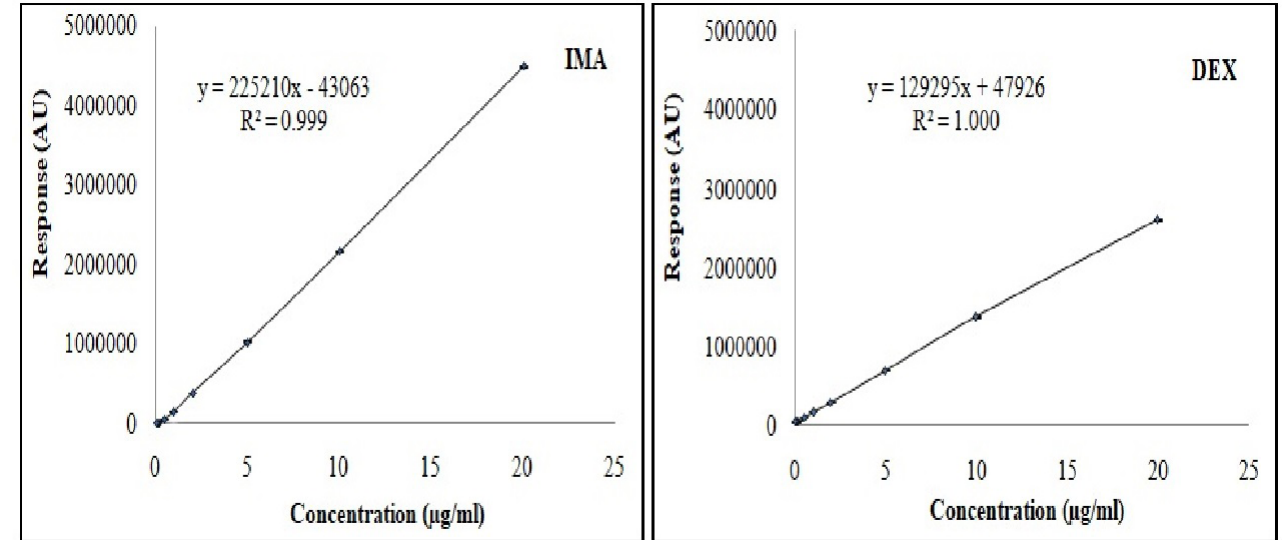
FIGURE 5 - The calibration curves of imatinib mesylate and dexketoprofen trometamol in DMEM (n= 6).